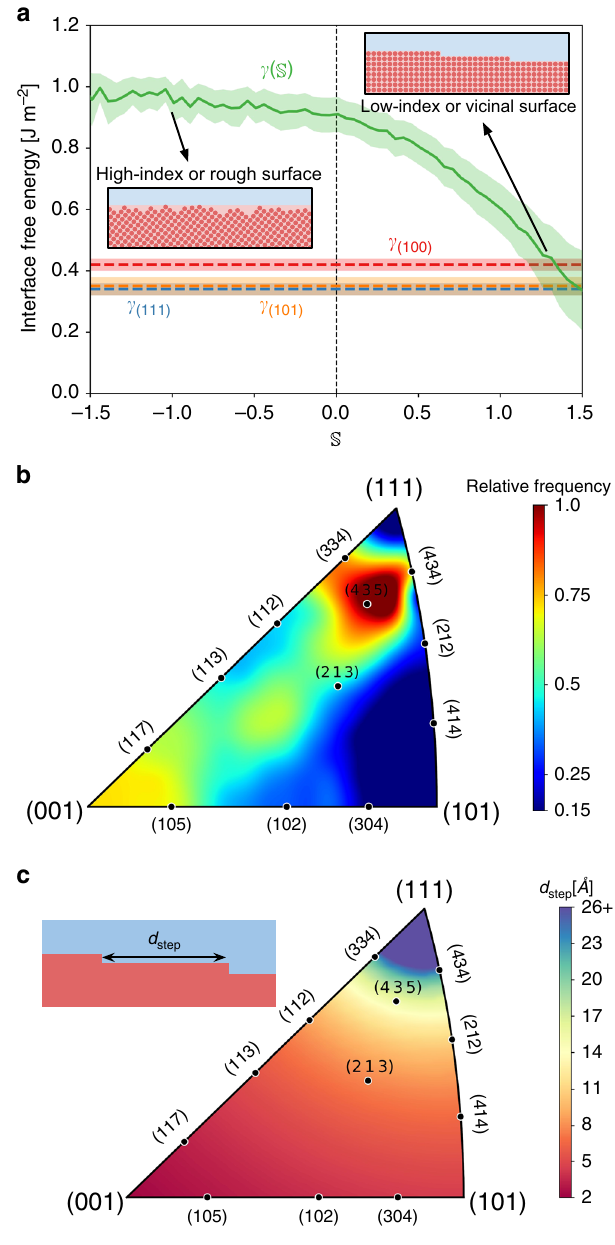
Fig. 6 Interface structure effect on crystal growth. a Free energy of the solid – liquid interface to which atoms with softness S attach. Large positive values of S have interface free energies characteristic of low-index interfaces in silicon, while negative values of S are found to be associated with high-index interfaces. Interfacial free energies γ (100) , γ (101) , and γ (111) and their respective error bars were obtained by Shou and Pan 66 . The error bar of γ ð S Þ is the standard deviation. b Distribution of interfaces to which the crystallizing atoms attach, showing a strong preference for (111) vicinals and a smaller amount of crystallization events on high-index interfaces. c Step – step separation distances ( d step ) for steps on (111) surfaces. Interfaces for which d step is much larger than the interatomic distance are vicinals (i.e. composed of (111) facets well separated by steps), while interfaces with d step of the order of the interatomic distance are high-index interfaces in which individual steps cannot be discerned